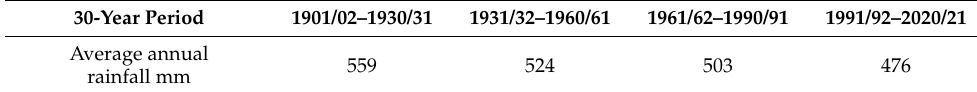
Table 3. Average annual rainfall levels for the four 30-year periods since 1901.